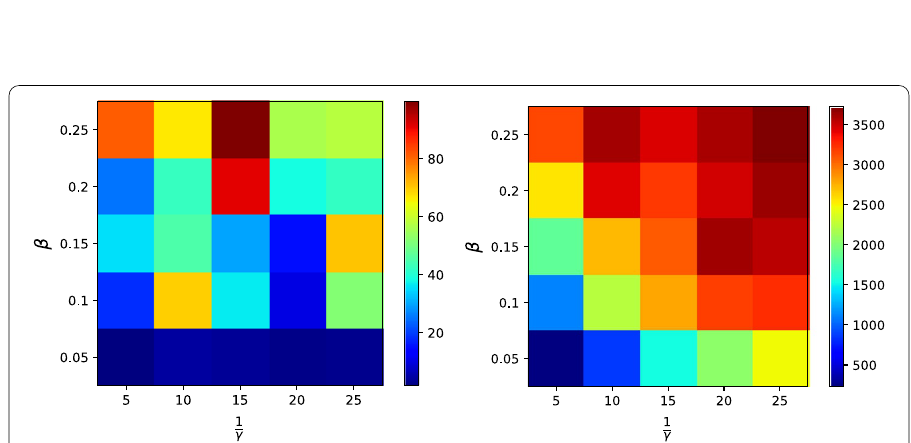
t I t | . IB Centrality maintains a seemingly “flat” 0 | (cid:31)